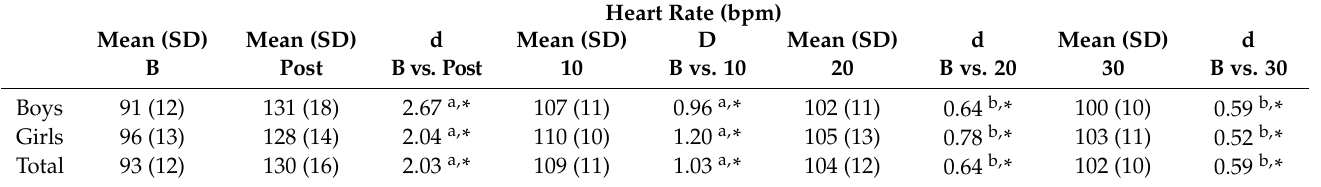
Table 4. Effect of a Muay Thai session on heart rate recovery in adolescents with overweight/obesity.